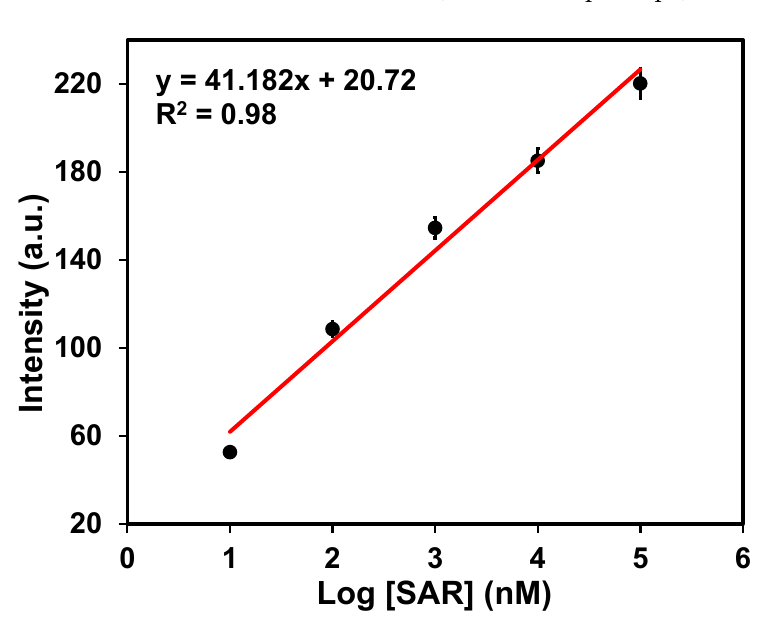
Figure 5. Calibration curve between intensity recorded with different concentrations of sarcosine. By substituting the values of SD of the intercept and the slope in the above Equation (3), the LOD is found to be 1.76 nM. (The detailed calculation of the LOD is described in the Supplementary Materials). Here, in our case, we anticipated that the coupling of Whispering Gallery Modes and photonic nano-jets in SiO 2 nanospheres induce Localized Surface Plasmon Resonance (LSPR) in Ag nano-islands, which is responsible for the SERS enhancement. Moreover, SiO 2 nanospheres act as nano-lens, so it is able to detect a very small amount of biomarker; consequently, the LOD is